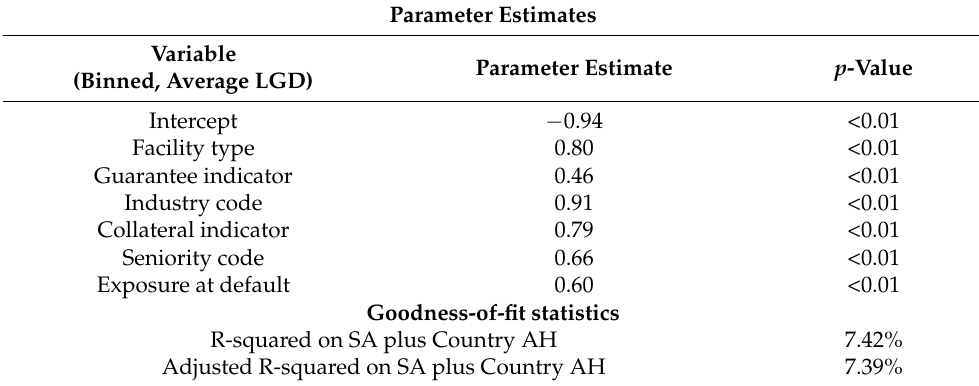
Table 9. Regression of South Africa GCD build data plus Country AH (Data set Q +